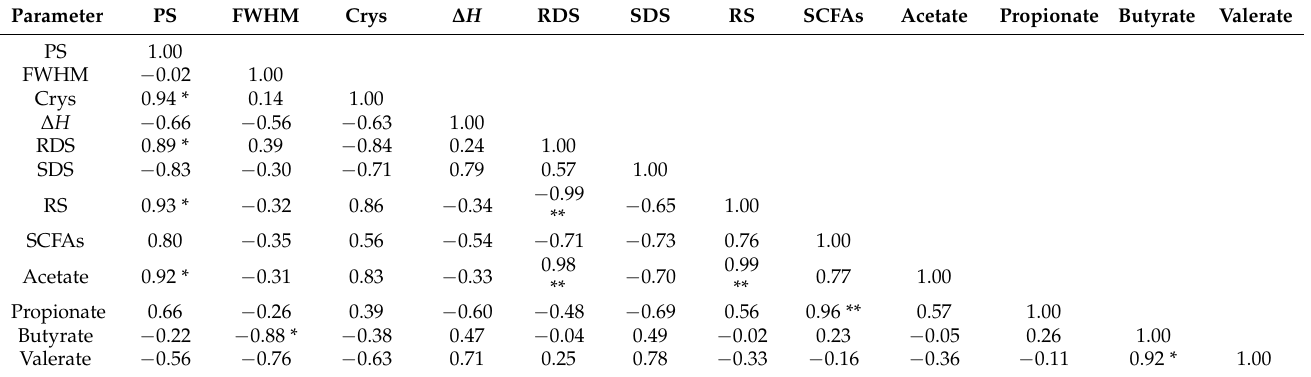
Table 3. Pearson’s correlation matrix of different parameters of raw and sand-roasted highland barley flours (control variable: sand